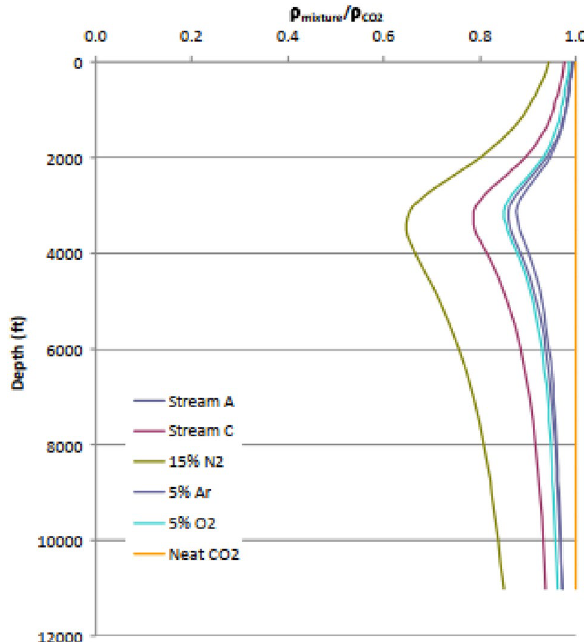
Fig. 5 Mixture density relative to the depth (Wang et al.